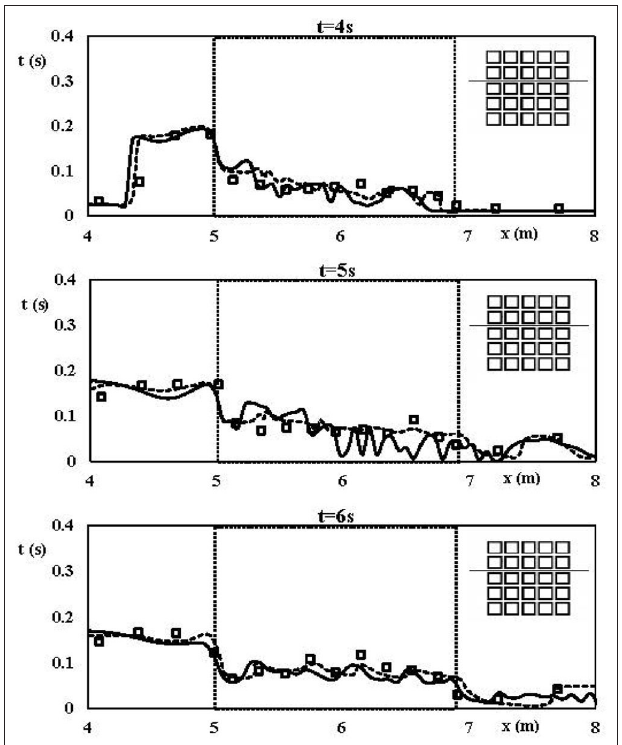
FIGURE 6 | Test case III. Experimental dam break flow through an idealized city of Soares-Frazão and Zech (2008). Free surface profile at 4,5, and 6 s along the third longitudinal street, as indicated by the sketch. Solid line: DBE numerical results. Dashed line: Soares-Frazão and Zech (2008) numerical results. Dots: Soares-Frazão and Zech (2008) experimental values. Dotted box: area occupied by the buildings.